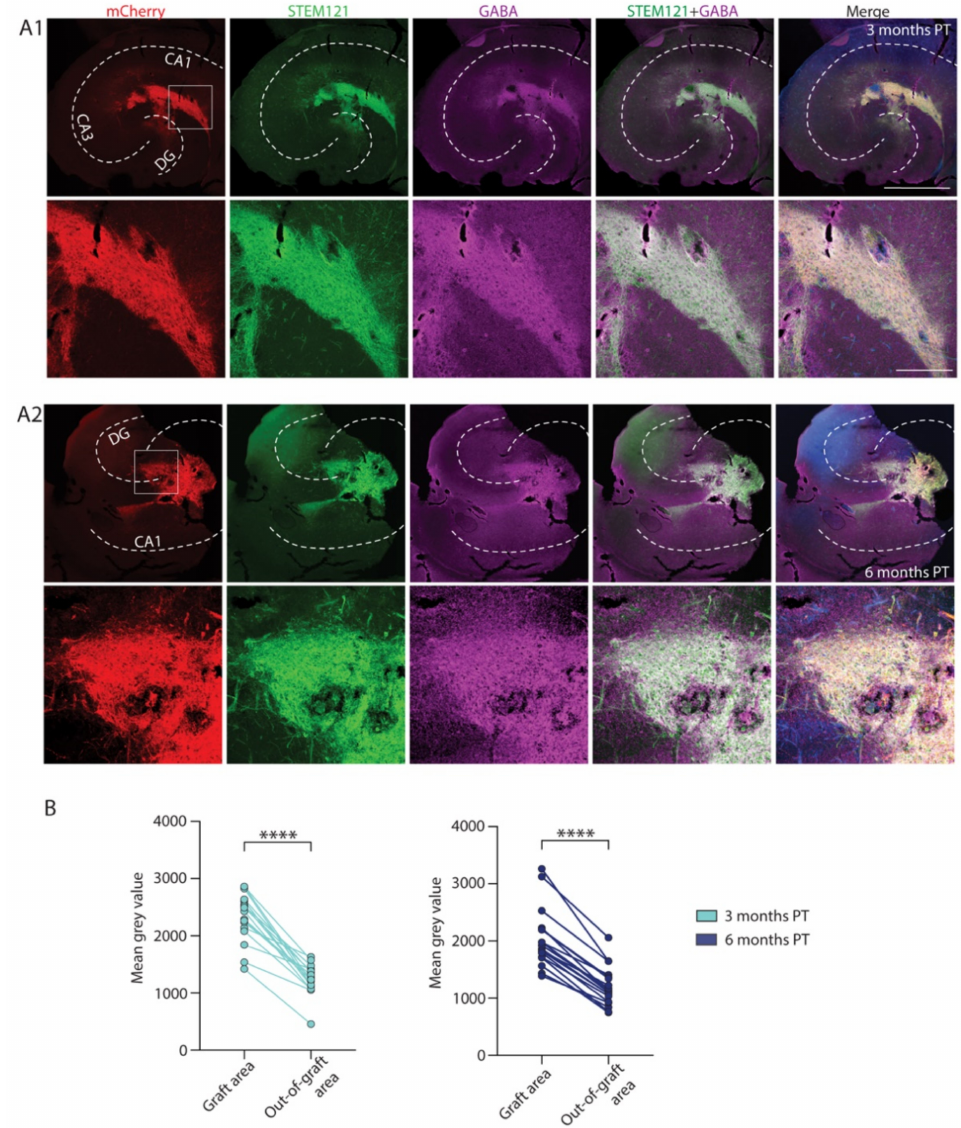
Figure 6. Histological analysis of GABA expression within and outside the graft. ( A ) Immunofluo- rescent staining of hippocampal sections with grafted hdInts for mCherry (marker for ChR2; red), human cytoplasm (STEM121; green), and GABA (magenta), merged with Hoechst (blue) in the last right column. GABA expression within the graft was well seen at both three months PT ( A1 ) and six months PT ( A2 ). ( B ) Quantification of GABA fluorescence intensity of the graft area compared with surrounding tissue at both timepoints. ****, p < 0001. Wilcoxon test was used in ( B ). Dashed white line in ( A1 , A2 ) represents the anatomical structure of the hippocampus. Scale bars 1 mm and 200 µ m. DG, dentate